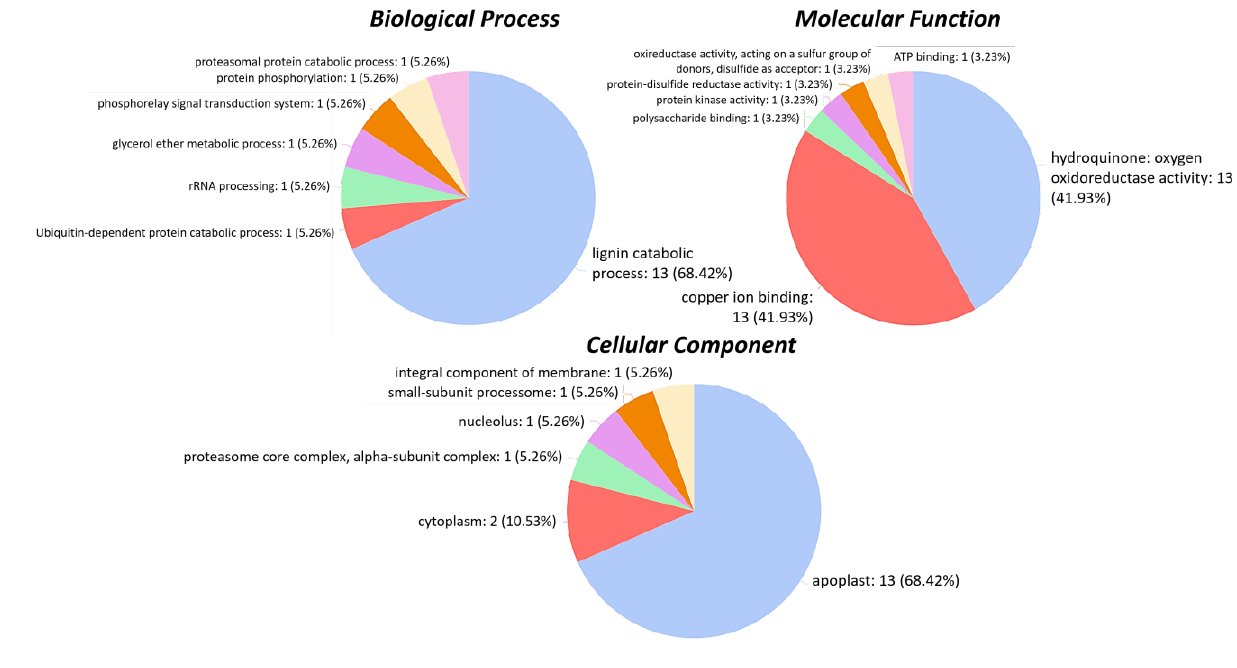
Figure 5. Pie charts of GO enrichment for target genes of miRNAs downregulated by HTT — 40 °C in R. irregulare -inoculated grapevine plants. GO terms are shown sorted highest to lowest.